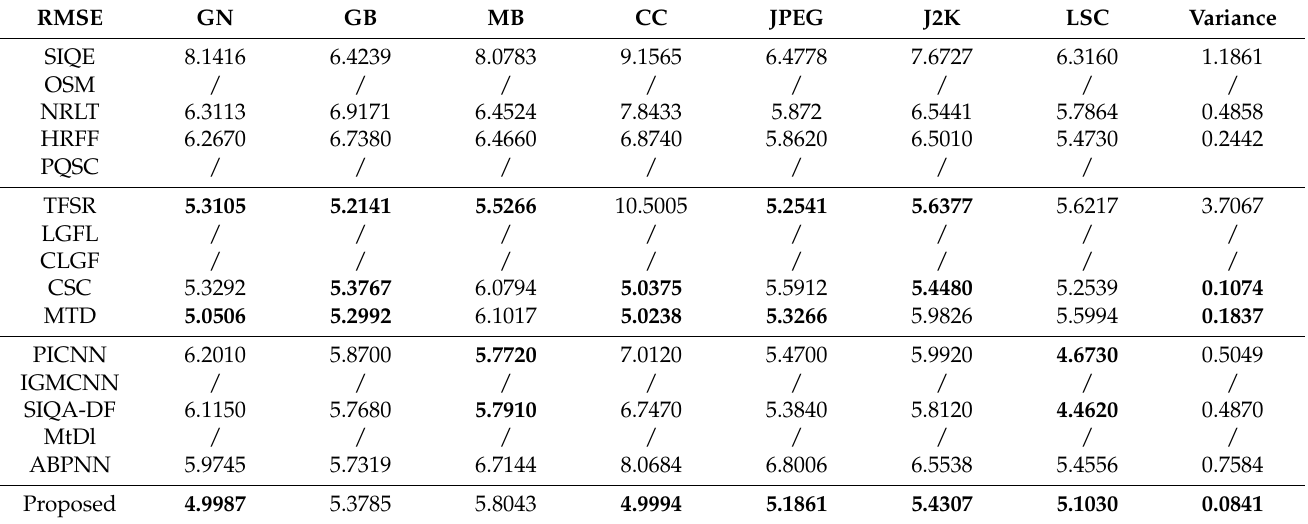
Table 6. RMSE results of different distortion types for the proposed and other methods on